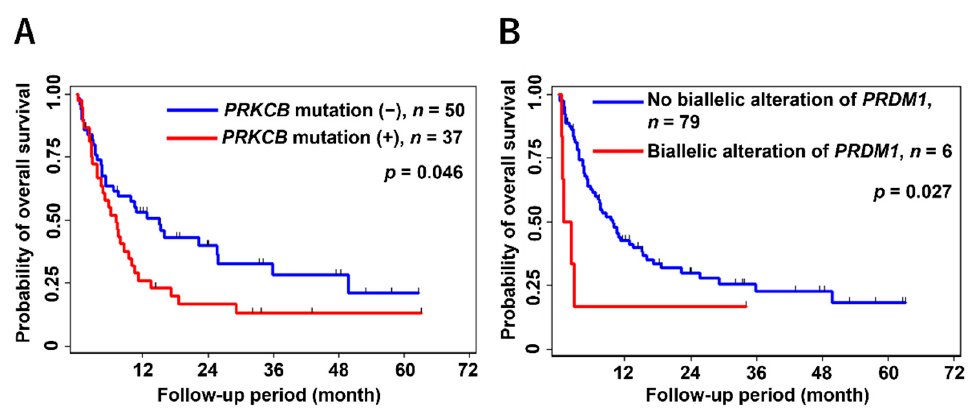
Figure 4. Kaplan–Meier survival curves for PRKCB mutation ( A ) and biallelic inactivation of PRDM 1 ( B ) in aggressive ATLL [17]. Statistical significance was evaluated with the log-rank test. Cutaneous lesions are one of the characteristic manifestations of ATLL [27]. Cutaneous involvement is categorized into patch, plaque, multipapular, nodulotumoral, erythro- dermic, and purpuric [90,91]. These types of lesions are reported to be associated with the clinical course [29,90,91]. Several researchers have proposed the cutaneous type as a new entity, in addition to the classical Shimoyama classification [27], based on their clinical and biological features [92,93]. Notably, Miyata et al. [93] revealed that there were distinct genomic profiles between erythema/papule and nodule/tumor types in skin lesions of pa- tients with ATLL. However, details regarding the genetic alterations of cutaneous in- volvement and their clinical significance remain unknown. The heterogeneities of genetic alterations in tumor cells across organs should be elucidated. Although many researchers have made an effort to elucidate ATLL pathogenesis, the roles of genetic alterations in clinical states are not fully understood. Given the variations in the characteristics of patients and the kinds of specimens that have been collected among the cohorts, more evidence needs to be accumulated. Of note, analysis that takes into account disease subtype and comparison with known prognostic factors is recom- mended [83,84]. 11. Phylogenetic Classifications of HTLV-1 Strains There are an estimated 10–20 million HTLV-1-infected individuals in the world, and the main endemic areas are Central Africa, South America, the Caribbean coast, Melane- sia, and Southwestern Japan [77]. HTLV-1 is classified into four major subtypes, namely Cosmopolitan subtype A, Central African subtype B, Central African/Pygmies subtype D, and Australo-Melanesian subtype C, based on phylogenetic analysis of the 5 ′ -long termi- nal repeat (LTR) sequence [77,94–97]. Cosmopolitan subtype A, which is widely distrib- uted worldwide, is further subdivided into four subgroups: Transcontinental, Japanese, West African, and North African [77,98]. The nucleotide sequence of the tax gene has also been employed in phylogenetic classification. Furukawa et al. [99] identified that HTLV- 1 in Japan comprises the tax A subgroup (HTLV-1- tax A) and the tax B subgroup (HTLV-1- tax B), corresponding to the Transcontinental and the Japanese subgroups, respectively. We previously surveyed the tax subgroup in 29 HTLV-1 carriers, 74 patients with ATLL, and 33 patients with HAM in Okinawa Prefecture [100]. We found 60 cases with HTLV-1- tax A (44%) and 76 cases with HTLV-1- tax B (56%), which was different from the distribution of those in mainland Japan (11% for HTLV-1- tax A and 89% for HTLV-1- tax B) reported by Furukawa et al. (Figure 5) [99]. Residents of Okinawa Prefecture have a his- torically and genetically distinct background from those of mainland Japan [101,102], a factor that might underlie this difference.